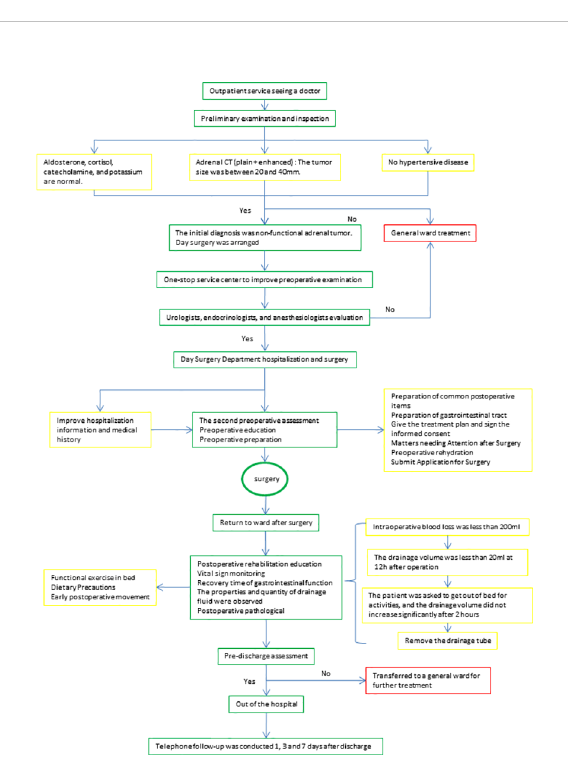
FIGURE 1 Diagnosis and treatment Procedures. After the initial selection, the patients were assigned to a one-stop service center to complete the preoperative examination. Hospitalization and surgery in the day surgery unit after assessment by the urologist, endocrinologist and anesthesiologist. After surgery, the choice of removal of the drainage tube and discharge was